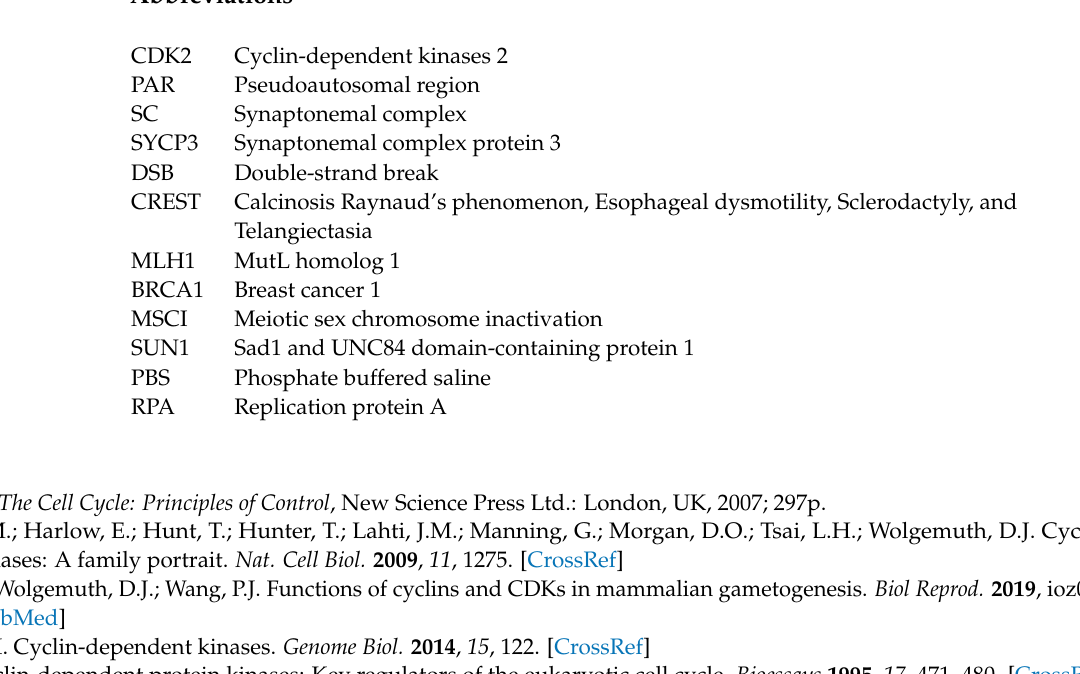
Figure S1. CDK2 distributions in prophase I sex chromosomes of different rodent taxa. Figure S2. CDK2 distributions in pachytene meiocytes of different rodents. Figure S3. CDK2 distributions in prophase I spermatocytes of Microtus arvalis . Figure S4. Multi round/multistep sequential immunostaining procedure. Table S2. Rodent sex bivalents and CDK2 foci in spermatocytes at the early - mid pachytene stage. Figure S5. A number of CDK2 foci (M ± SEM) per asynaptic part of the sex chromosome in pachytene meiocytes of different rodents. Table S3. Colocalization and non-colocalization of SUN1 and CDK2 foci in autosomal bivalents and sex bivalents of rat and mole vole spermatocytes at the mid pachytene stage. Table S4. Colocalization and non-colocalization of MLH1 and CDK2 foci in autosomal bivalents of rat and mole vole spermatocytes at the mid pachytene